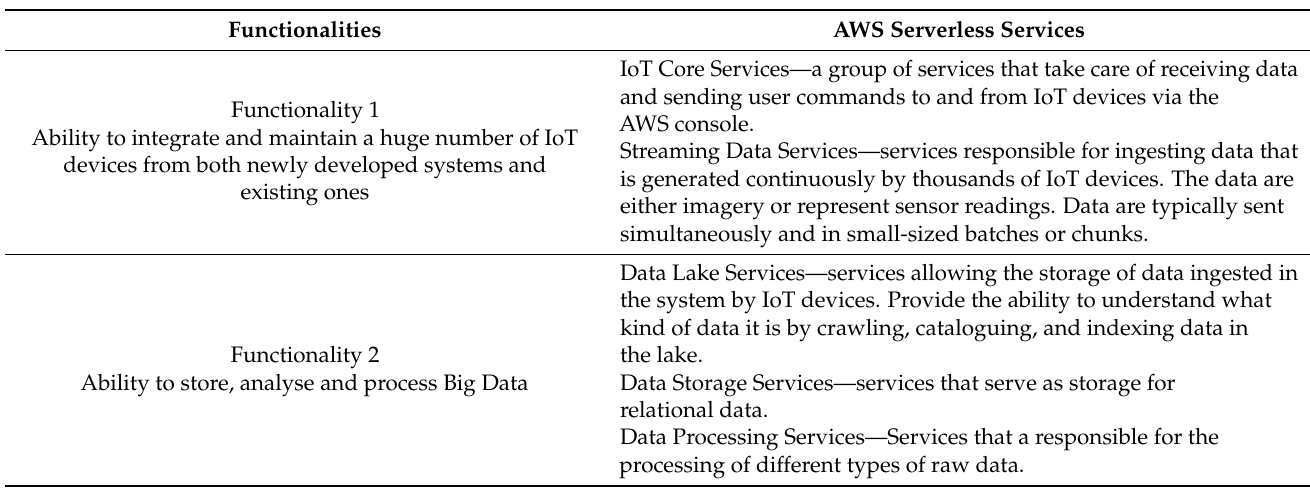
Table 1. Groups of AWS services that fulfil system functional